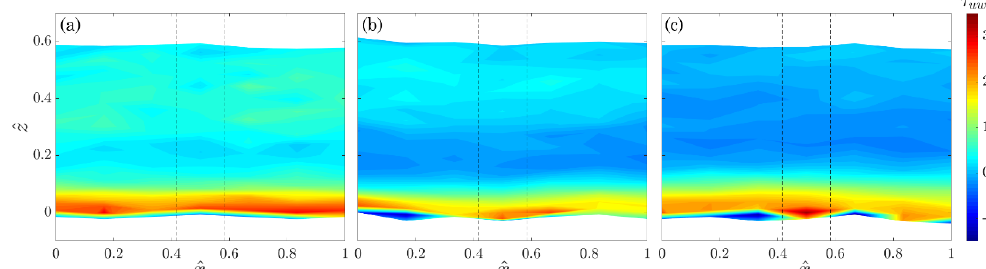
Figure 3. Contours of dimensionless Reynolds shear stresses measured on the vertical central plane for ( a ) Run 1, ( b ) Run 2, and ( c ) Run 3. The black broken lines indicate the edge of the vegetation stem.